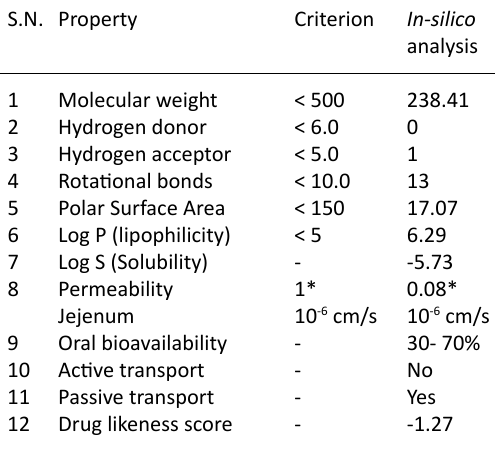
Table 1. In-silico prediction of physico-chemical and pharmacokinetic property of